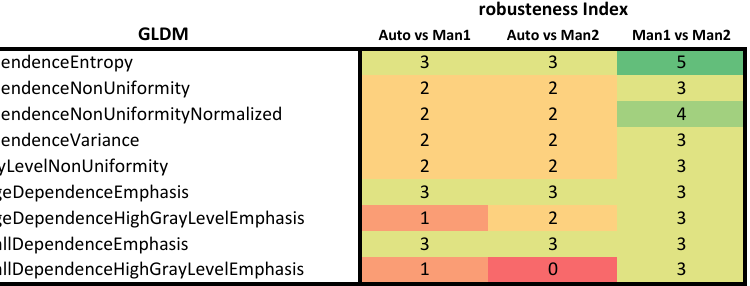
Figure 10. Robustness of the GLDM radiomic features obtained on DCE-MRI images using automated segmentation against two manual segmentations from two independent readers.